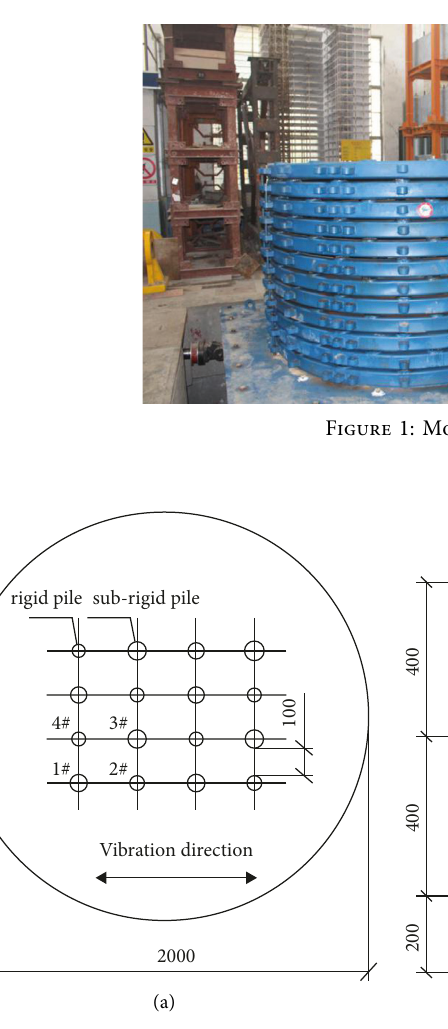
Figure 2: Layout of test piles: (a) plan view and (b) sectional view. Table 1: The loading conditions of this test.